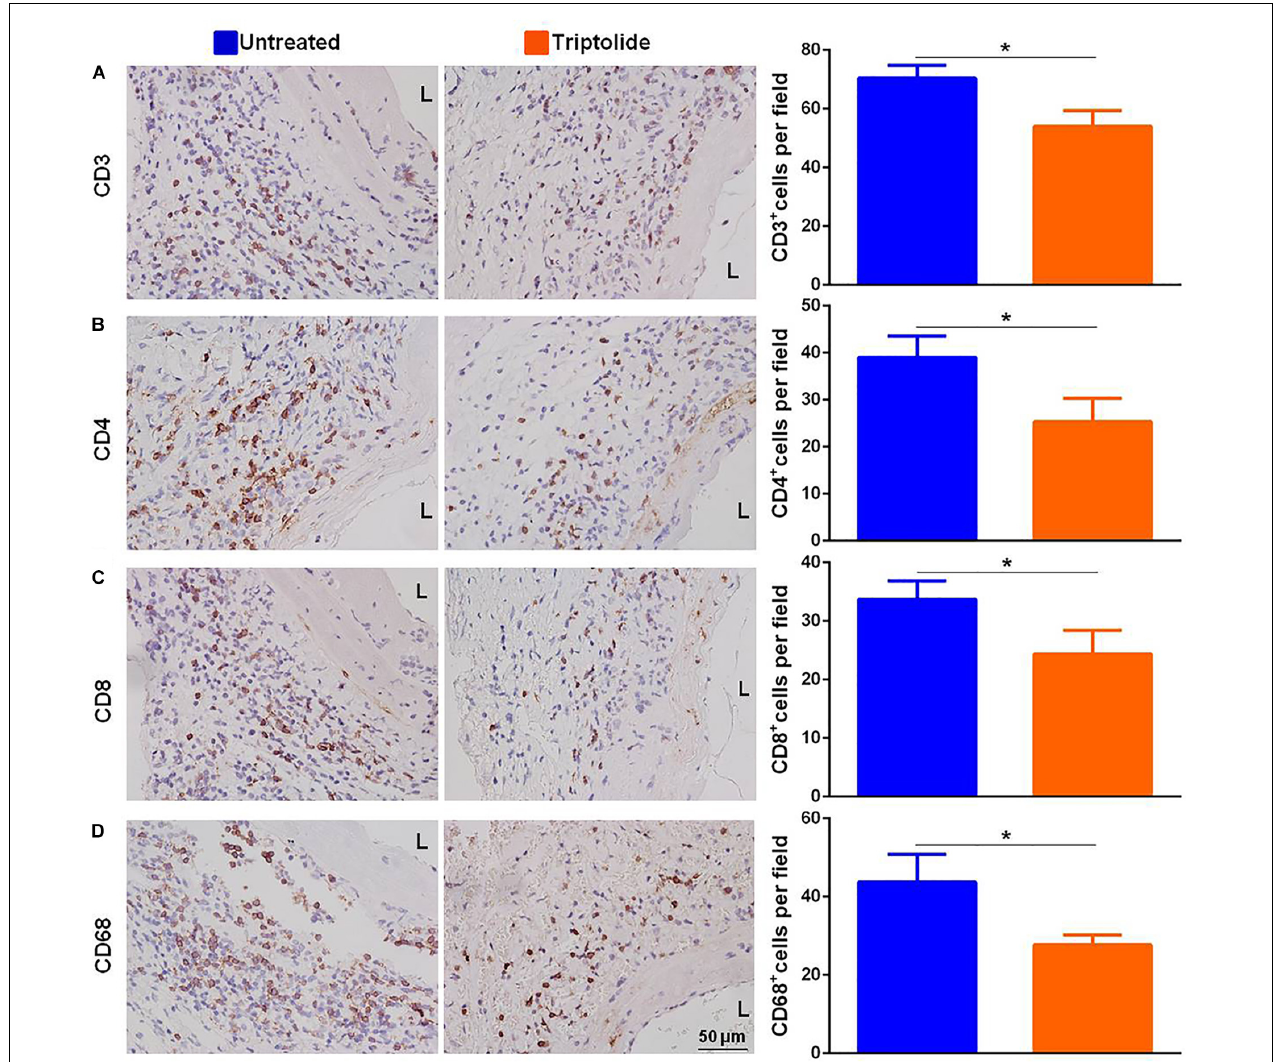
FIGURE 2 | Triptolide decreases T lymphocyte and macrophage infiltration in allografts. Representative images and quantification of (A) CD3 + , (B) CD4 + , (C) CD8 + , and (D) CD68 + cell infiltration in TV lesions. The positive cells were counted by automated cell counting using IPP 6.0 imaging software and expressed as the number of positive cells per field of a vascular section (400 × magnification). Three independent experiments were performed and showed similar results. Data were expressed as mean ± SD. * p < 0.05 vs. untreated Student’s t -test. L, lumen.